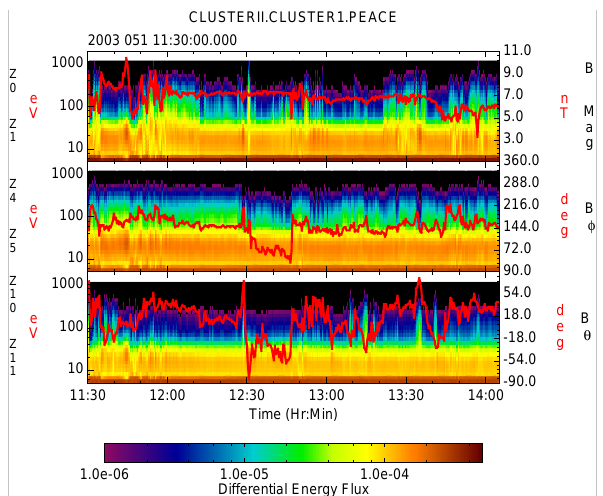
Fig. 5. Spectrograms of differential energy flux (ergscm − 2 -s-str- eV) from three heads of the PEACE LEEA instrument on C1 cov- ering the time period of the event being analyzed. The upper and lower panels are from the extreme upward and downward pointing heads while the center panel is from a near equator looking head. The red traces are overlays of the spherical GSE components of the magnetic